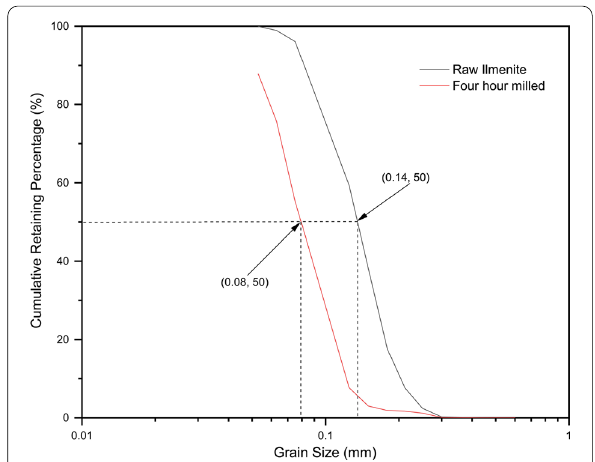
Fig. 2 Particle size distributions of initial ilmenite sample and four hours milled ilmenite